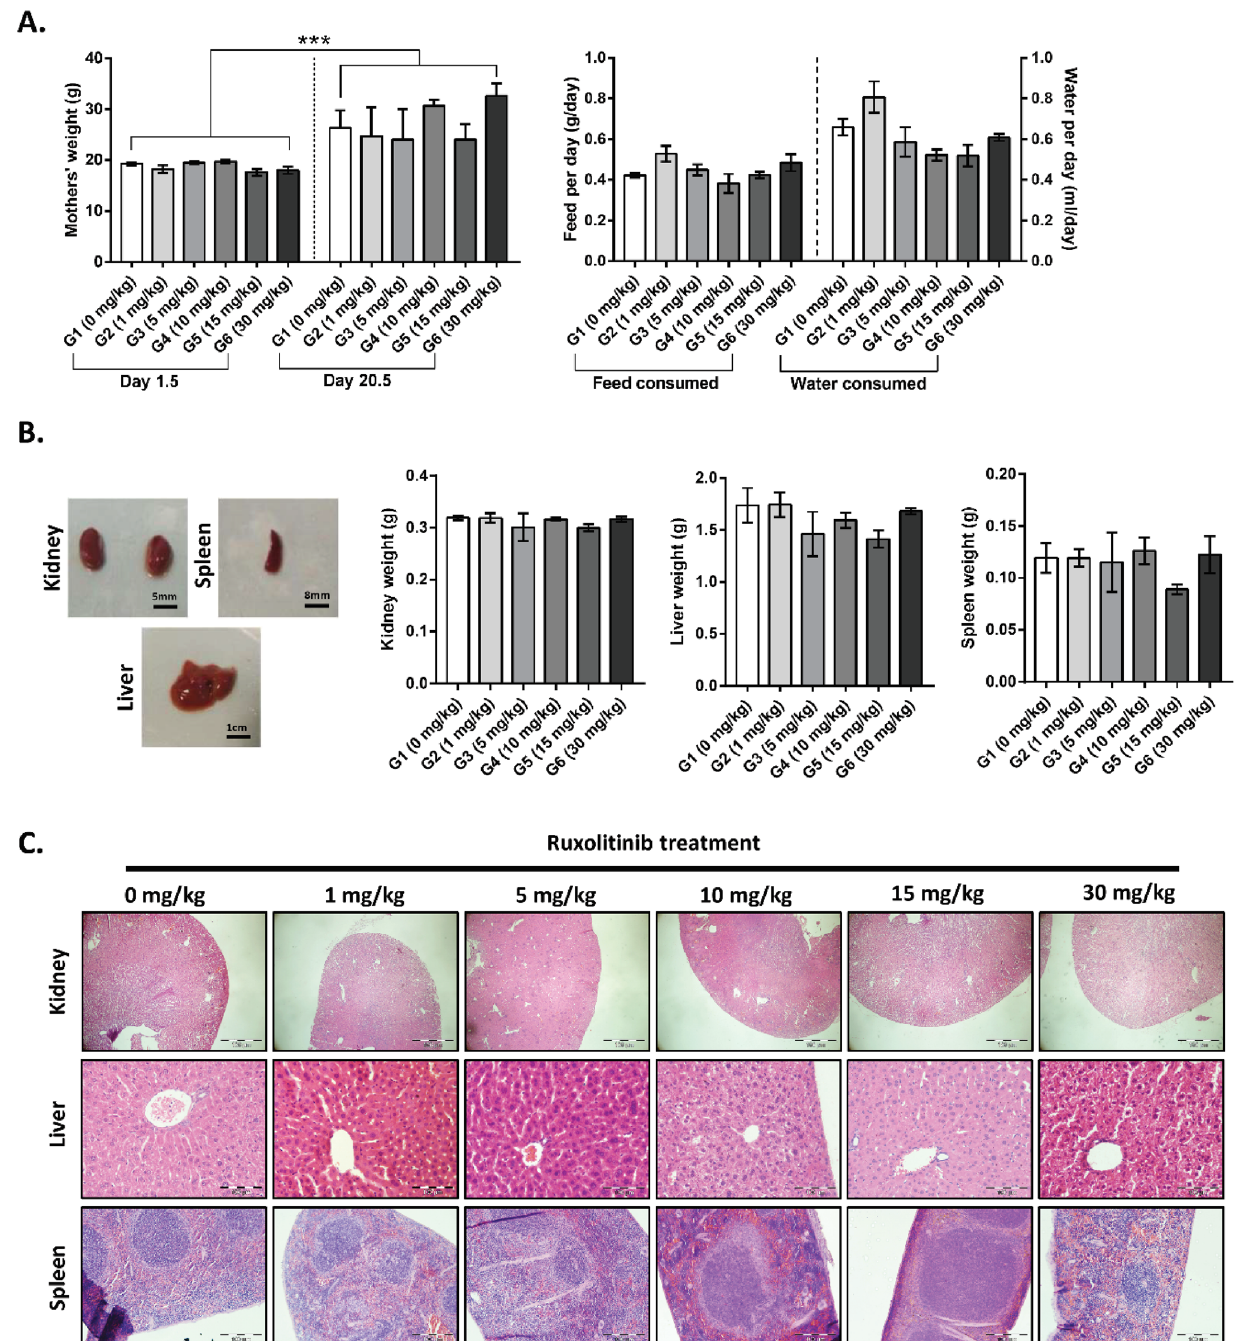
Figure 1. Behavioural, gross anatomical and histopathological assessments of pregnant mice underwent transient ruxolitinib treatment. ( A ) Analysis of weight (n = 3–7 per group for 1.5 day post-coitum and n = 3–6 per group for 20.5 day post-coitum; One-way ANOVA with Sidak’s multiple comparisons), and normalised feed and water consumptions (n = 3–6 per group; One-way ANOVA with Dunnett’s multiple comparisons) between G1 (0 mg/kg) vehicle control group and treated groups. ( B ) Representative figure for gross anatomical assessment and the weight of the kidney, liver and spleen (n = 3 per group; One-way ANOVA with Dunnett’s multiple comparisons) harvested from G1-G6 pregnant mice. ( C ) Representative haematoxylin and eosin staining of kidney, liver, and spleen sections (n = 3 per group) from G1-G6 pregnant mice. All values represent mean ± SEM; *** denotes adjusted p <